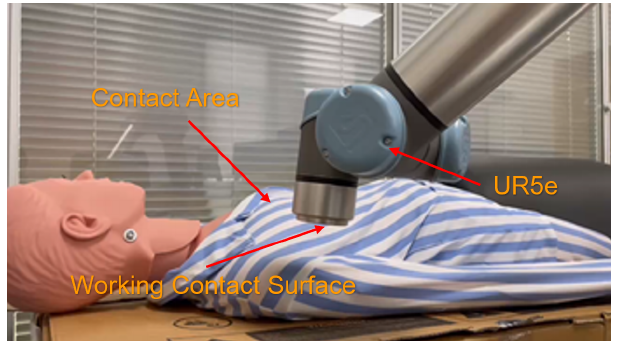
Figure 10. Construction of auscultation scene.